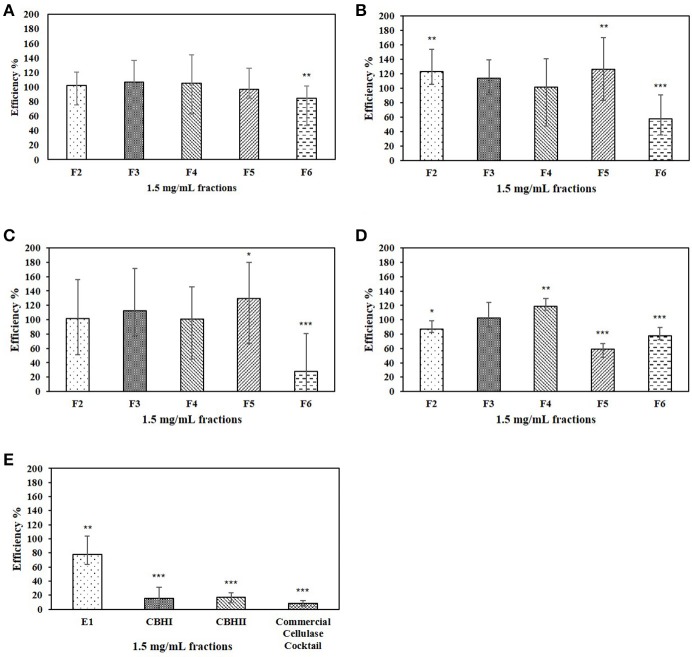
(A–D) Effects of CPC fractionated pinewood HW pre-hydrolyzate with a final concentration of 1.5 mg/mL on the enzymatic efficiency of E1, CBHI, CBHII and commercial cellulase cocktail during the cellulose-DNS assay; (E) Effect of 10% butanol solvent on the enzymatic efficiency of each cellulolytic enzyme. Symbol * represents the level of significance according to the double tailed t-test. Standard error bars were used to represent the deviation.